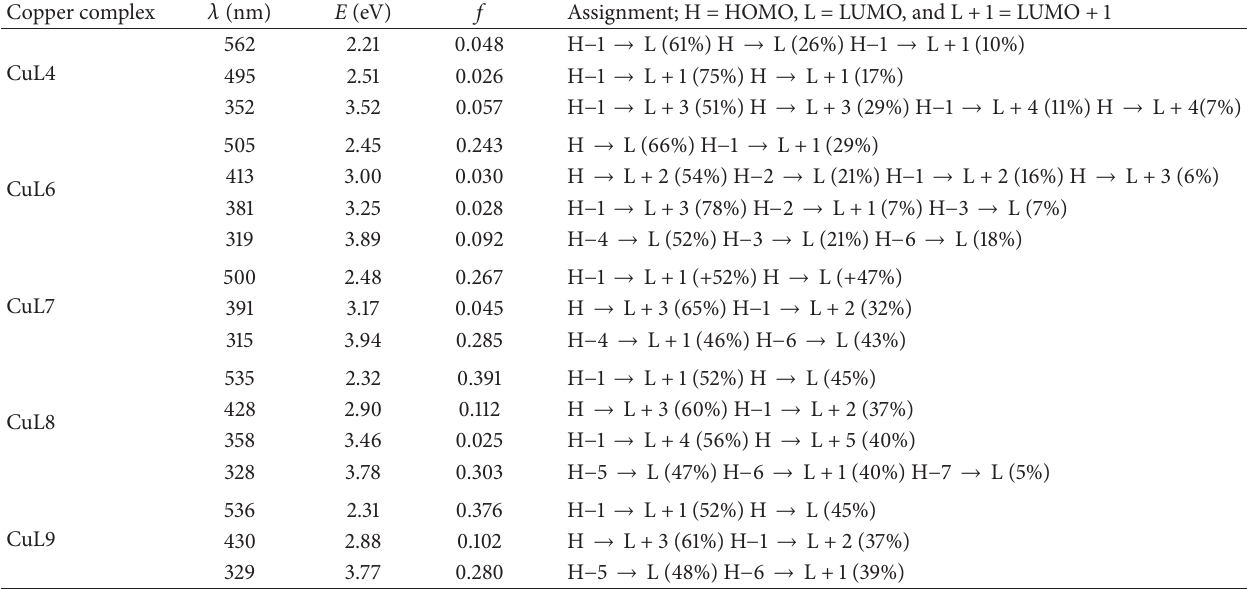
Table 2: Copper complexes electronic excited states, showing wavelengths (nm), energies (eV), oscillator strength ( 𝑓 ), and the orbitals involved in the transitions. Only excited states with f > 0.02 are shown. Copper complex